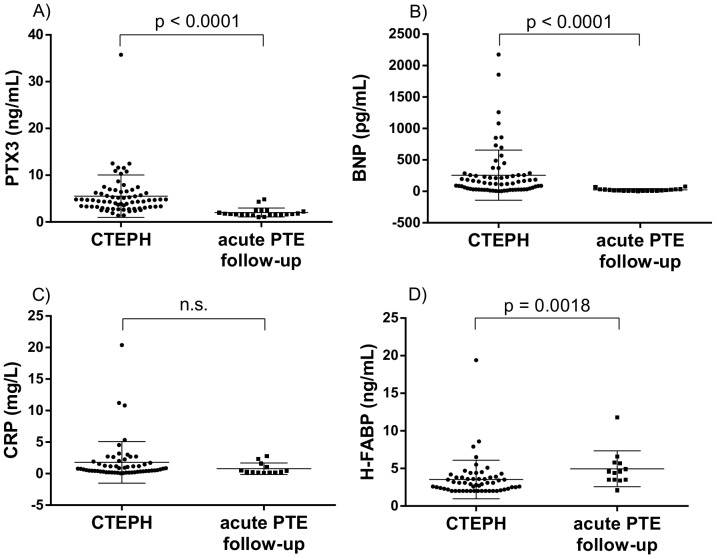
Plasma pentraxin3 (PTX3) and other biomarker's concentration in patients with CTEPH.A) PTX3 (ng/mL), B) BNP (pg/mL), C) CRP (mg/L), and D) H-FABP. Plasma PTX3 and BNP levels were higher in patients with CTEPH than in controls. The CTEPH patients tended to have higher plasma CRP levels than the control patients, although this difference was not statistically significant. Both groups had a low plasma H-FABP level which is considered to be almost normal [28], although control patients had statistically higher H-FABP level than CTEPH patients.